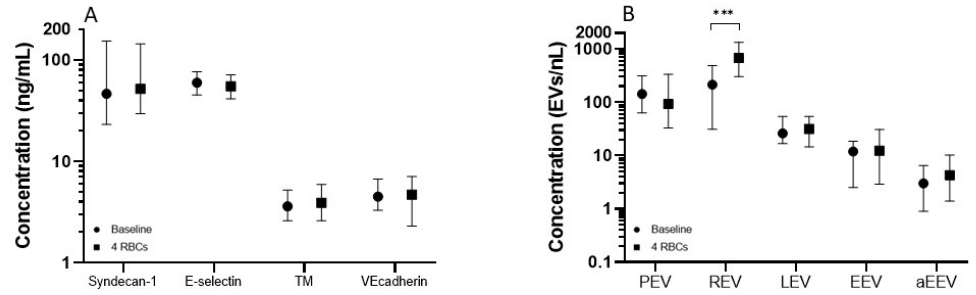
Figure 2. Median and interquartile ranges of levels of ( A ) endothelial activation markers on baseline and after transfusion and ( B ) Extracellular vesicles on baseline and after transfusion. A bar with asterisk represents a statistically significant difference, *** p < 0.001. Abbreviations: TM: thrombo- modulin, PEV: platelet derived extracellular vesicle, REV: red blood cell derived extracellular vesicle, LEV: leucocyte derived extracellular vesicles, EEV: endothelial derived extracellular vesicle, aEEV: activated endothelial derived extracellular vesicle.